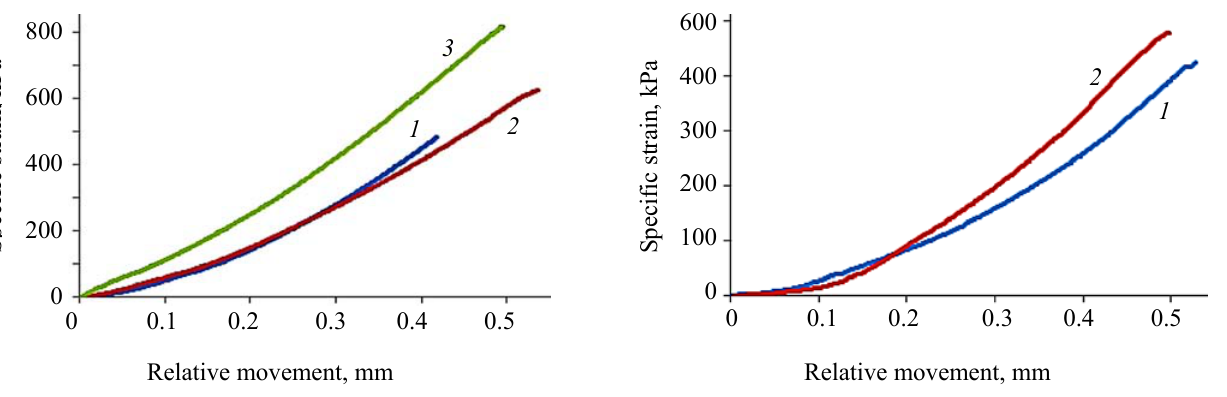
Fig. 2. Loading curves for the compression of carrot samples after 3 months of storage ( 1 ) Nantes carrots, ( 2 ) Toucheon carrots.